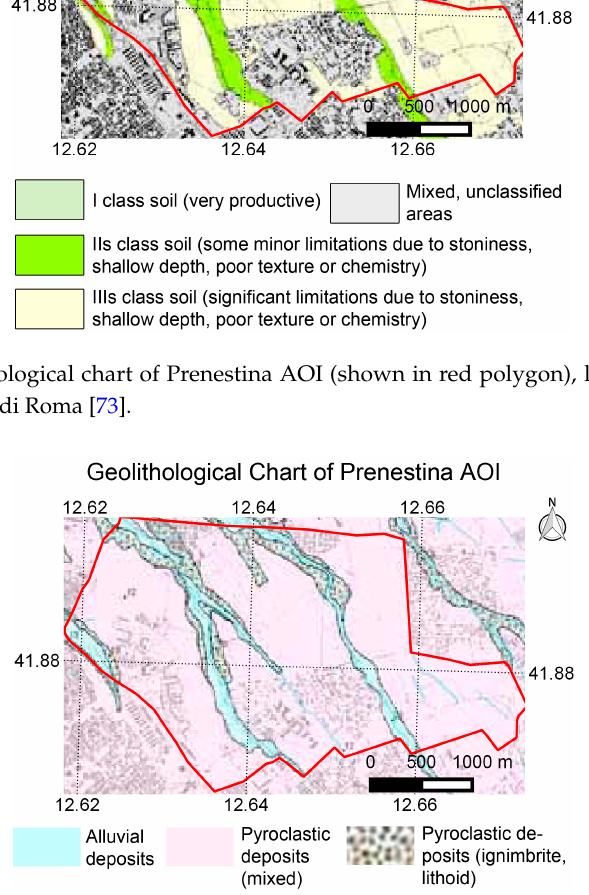
Figure 27. Geolithological chart of Prenestina AOI (shown in red polygon), last updated in 2007. Copyright: Comune di Roma [63].